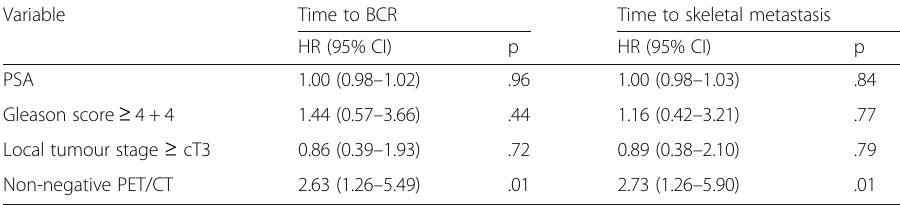
Table 2 Results of multivariable Cox regression analysis with hazard ratios for each variable for time to BCR and time to skeletal metastasis, with PSA as a continuous variable and Gleason score, local tumour stage and PET/CT findings dichotomized